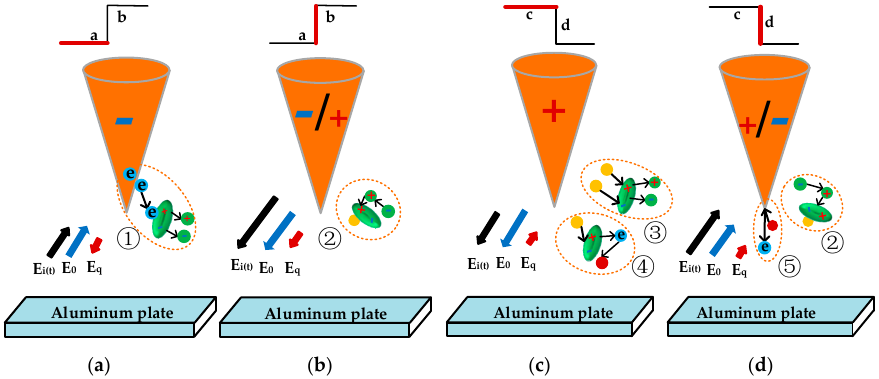
Figure 9. Change of space charge and electric field under square wave voltage. ( a ) Negative voltage, ( b ) rising flank, ( c ) positive voltage, ( d ) falling flank (elliptical green spheres: polymer molecules; green spheres: small molecule chains; yellow balls: photons; red balls: hot electrons).